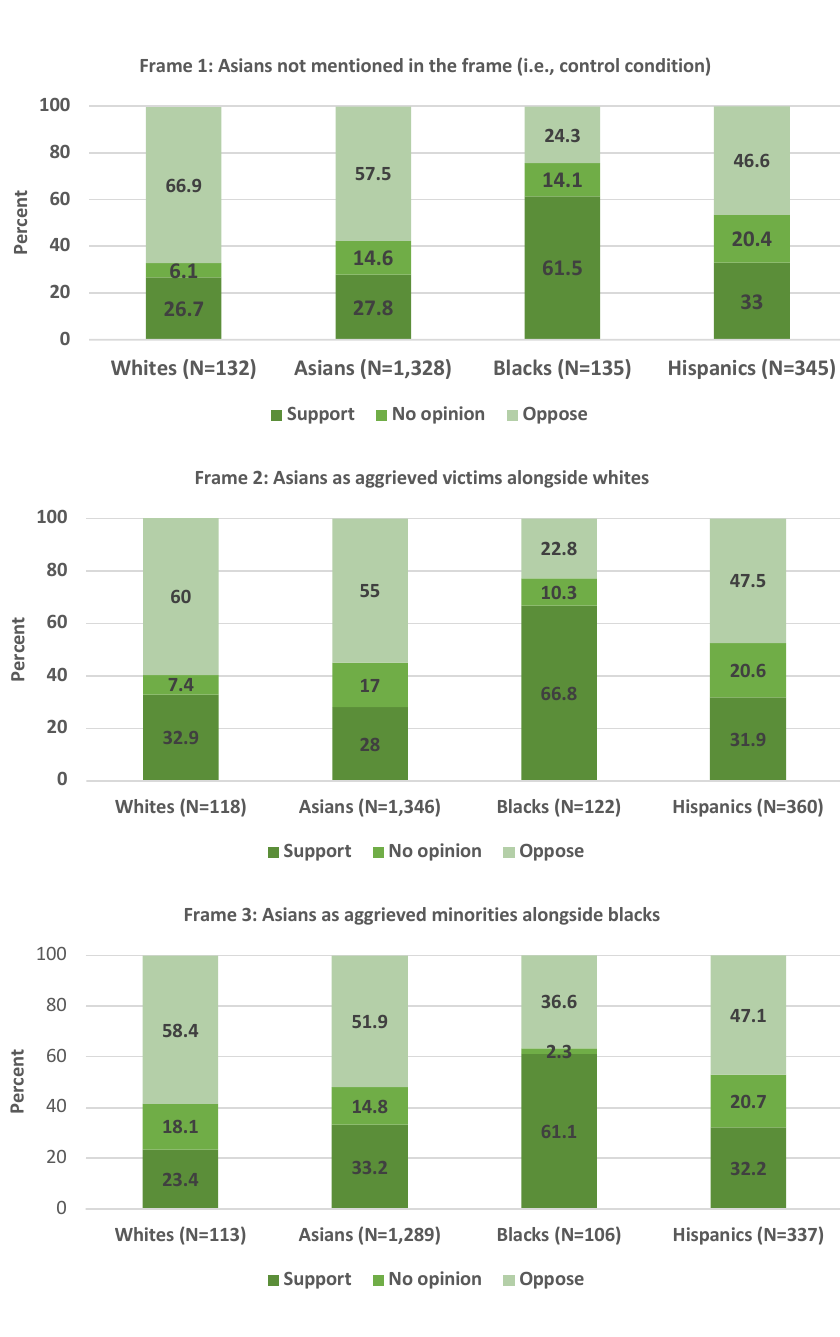
weighted percentages. Source: 2016 National Asian American Survey.